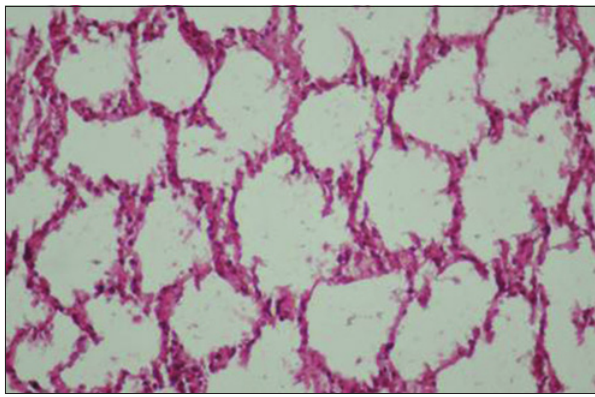
Figure-5: Lungs of polymerase chain reaction negative sheep for ovine pulmonary adenocarcinoma (negative control) (H and E,